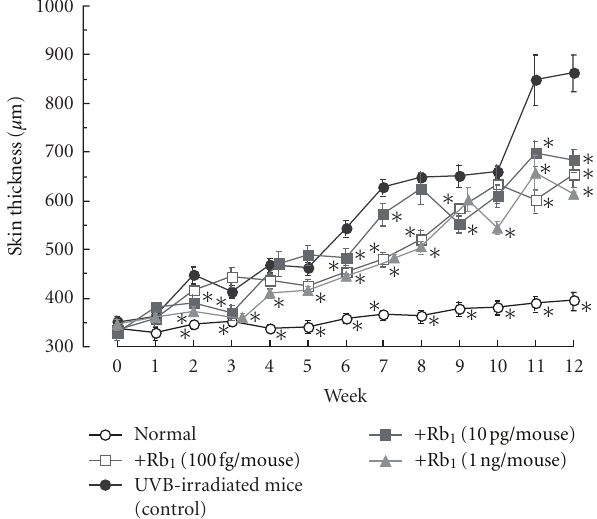
Figure 9: E ff ects of ginsenoside Rb 1 on skin thickness in chronic UVB-irradiated male hairless (HRM-1) mice [31]. The initial dose of UVB was set at 36 mJ/cm 2 , which was subsequently increased to 54mJ/cm 2 at weeks 1–4, 72mJ/cm 2 at weeks 4–7, 108mJ/cm 2 at weeks 7–10, and finally 122 mJ/cm 2 at weeks 10–12 in male albino hairless HOS: HR-1 mice. The frequency of UVB irradiation was set at three times per week. Ginsenoside Rb 1 (100 fg, 10pg, and 1ng/mouse) was applied topically to the dorsal region of each mouse every day for 12 weeks. The dorsal skin of the hairless mice was lifted up by pinching gently under anesthetization with pentobarbital, and skin-fold thickness was measured using a Quick Mini caliper. Skin thickness after UVB irradiation was measured every week. Values are the mean ± SE for 6 mice. ∗ Significantly di ff erent from vehicle-treated mice, P < 0 . 05.